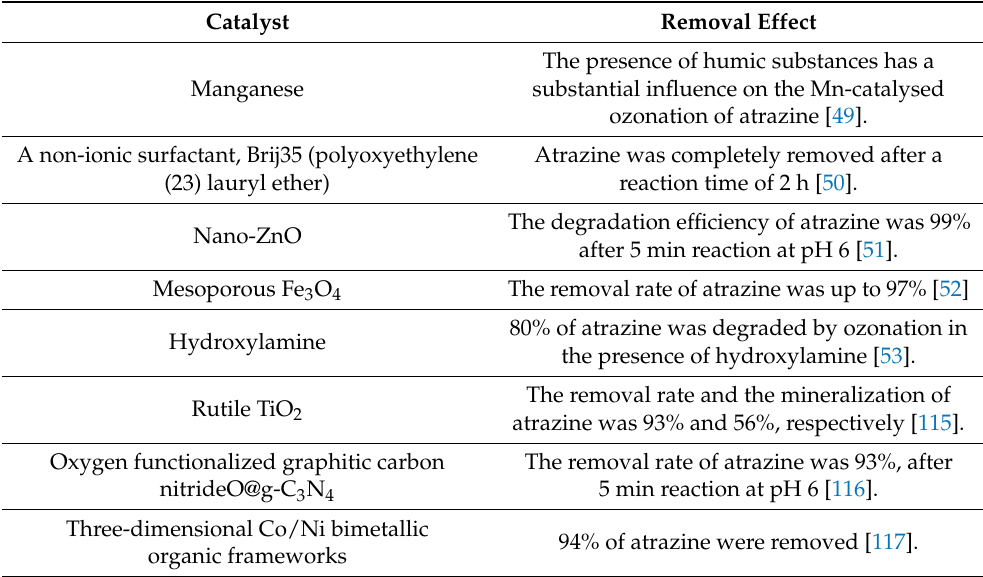
Table 4. Ozonation of aqueous atrazine.